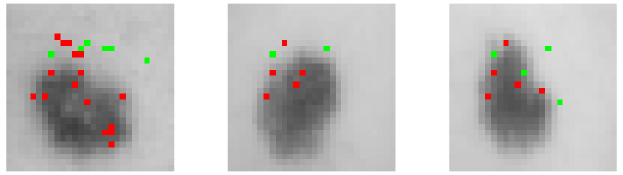
Figure 11. Three training samples belonging to the “malignant” class. The example in the middle is covered by a single rule, while the examples on the left and right activate four and two rules,